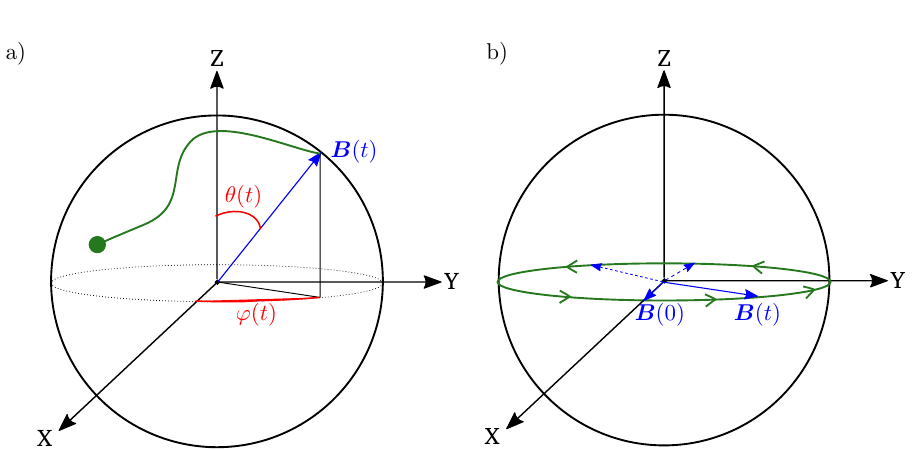
Figure 3: a) general description of the magnetic field of constant magnitude involved in the problem (blue), a general path that the field can follow over the surface of the sphere (green) and the parametrization of the path in terms of the polar angle θ and azimutal angle ϕ (red). b) The particular path ( θ ( t ) , ϕ ( t )) ∈ { ( π/ 2,2 π t ) | t ∈ [ 0,1 ] } studied in the